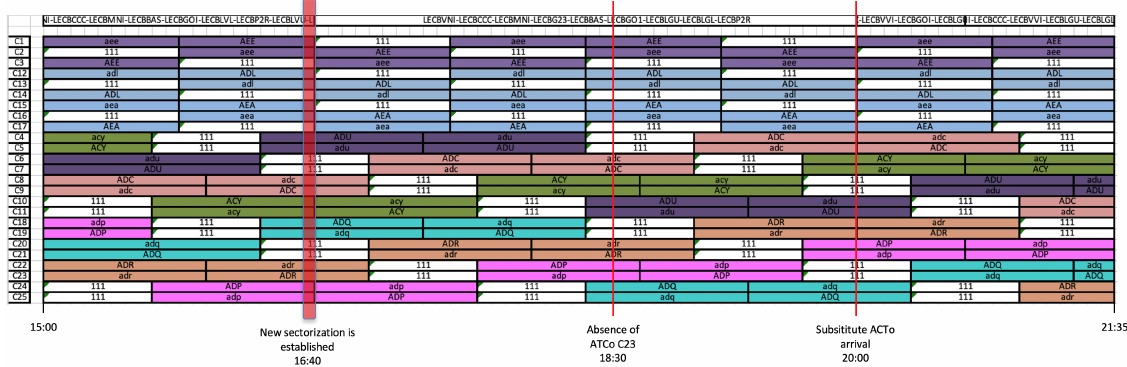
Figure 8. Initial solution before the incident of Barcelona control center (Instance